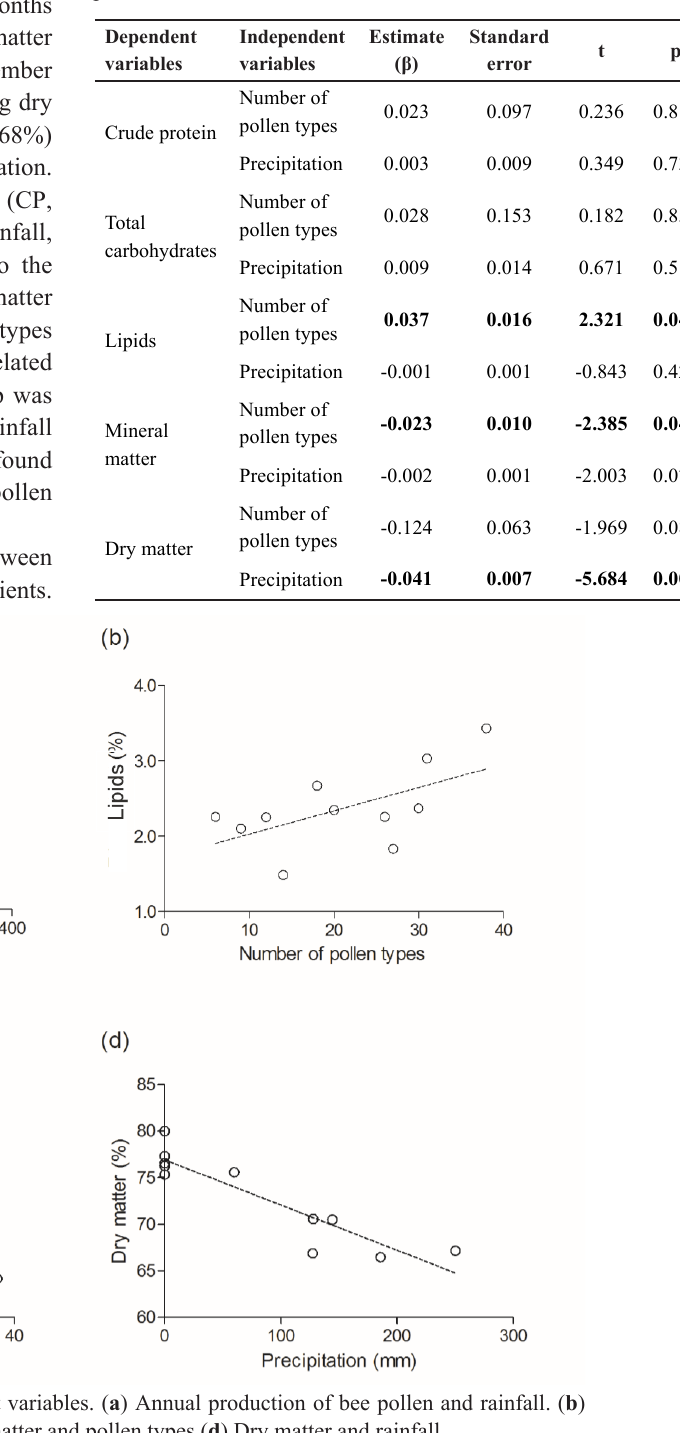
Table 2 . Results of generalized linear models (GLM) of factors that influence chemical variables of bee pollen produced by Apis mellif- era in a seasonal semideciduous forest in the State of Ceará, in the period from November 2012 to October 2013.